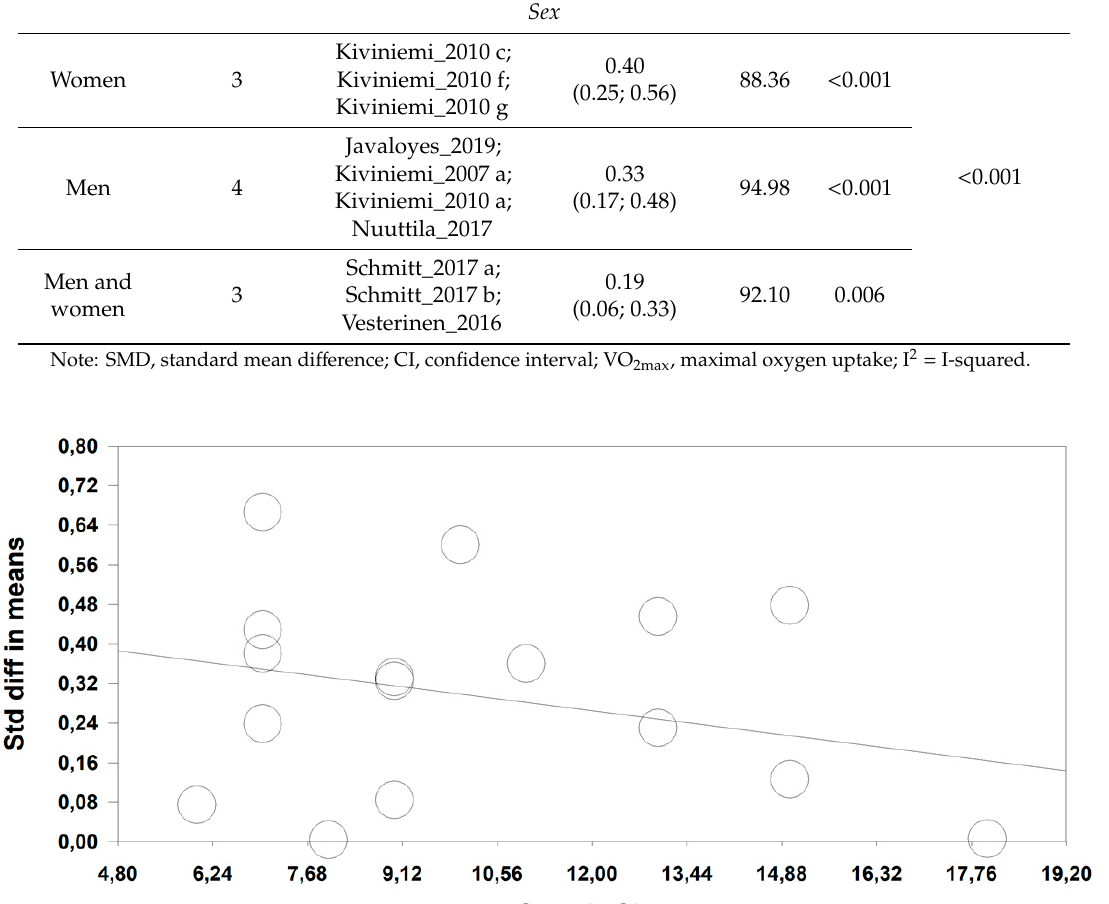
Table 3. Subgroup analyses for measuring their impact on VO 2max .